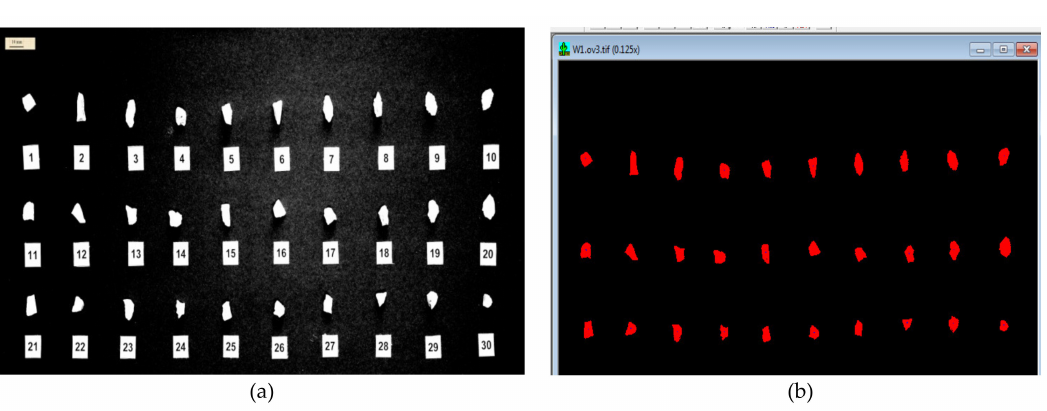
Figure 3. ( a ) Binary image (Scale bare: 10 mm) and ( b ) measurements of selected particle